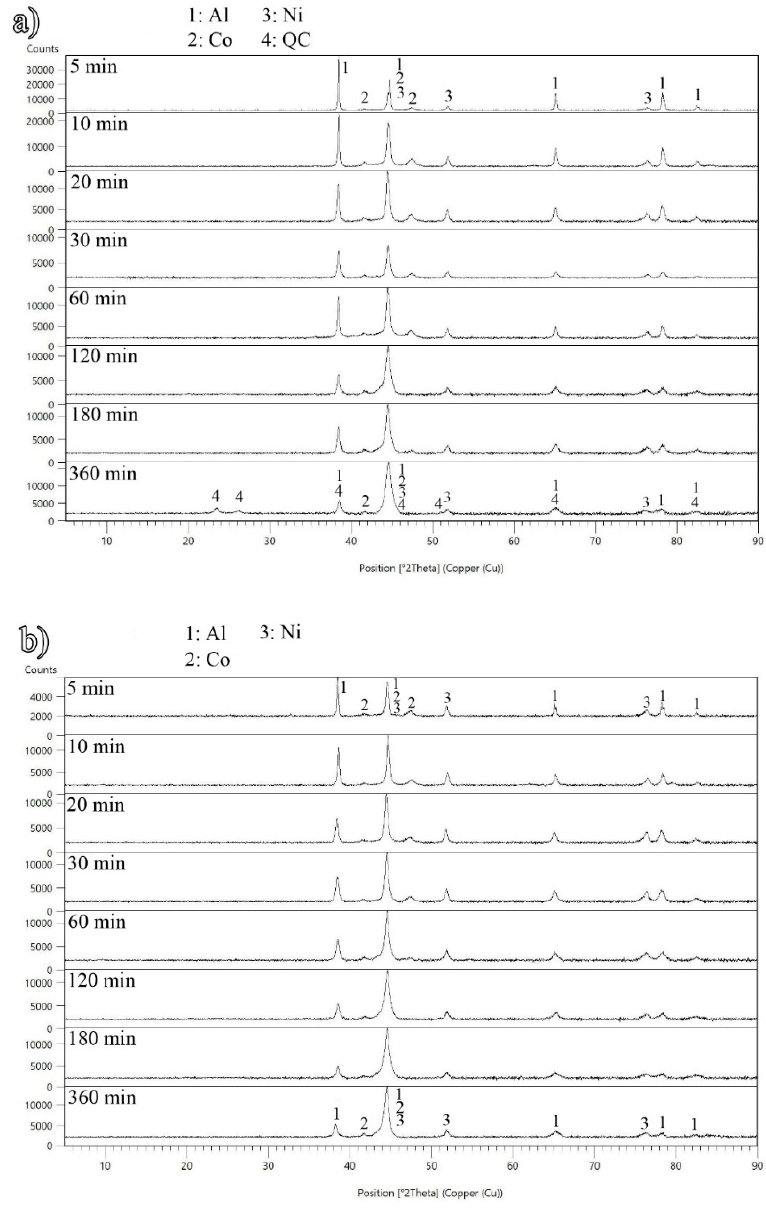
Figure 3. X-ray di ff raction patterns of the Al 70 Ni 15 Co 15 mixture after di ff erent milling times for the Figure 3. X-ray diffraction patterns of the Al 70 Ni 15 Co 15 mixture after different milling times for the ( a ) ( a ) coated and ( b ) raw powder specimens. coated and ( b ) raw powder specimens. Table 1. Indexing of electron di ff raction pattern (QC phase) in Figure 3a. Table 1. Indexing of electron diffraction pattern (QC phase) in Figure 3a. Di ff raction Ring